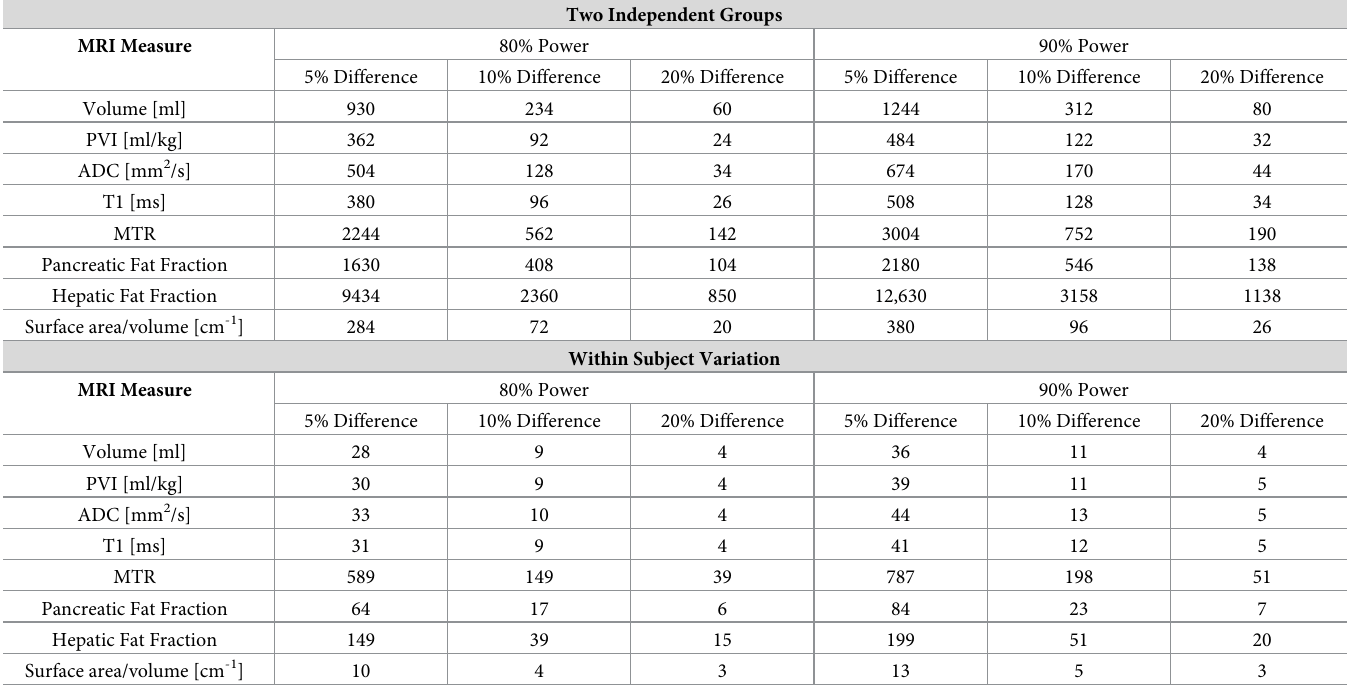
Table 3. Projected number of study participants required for future clinical trial (multisite).